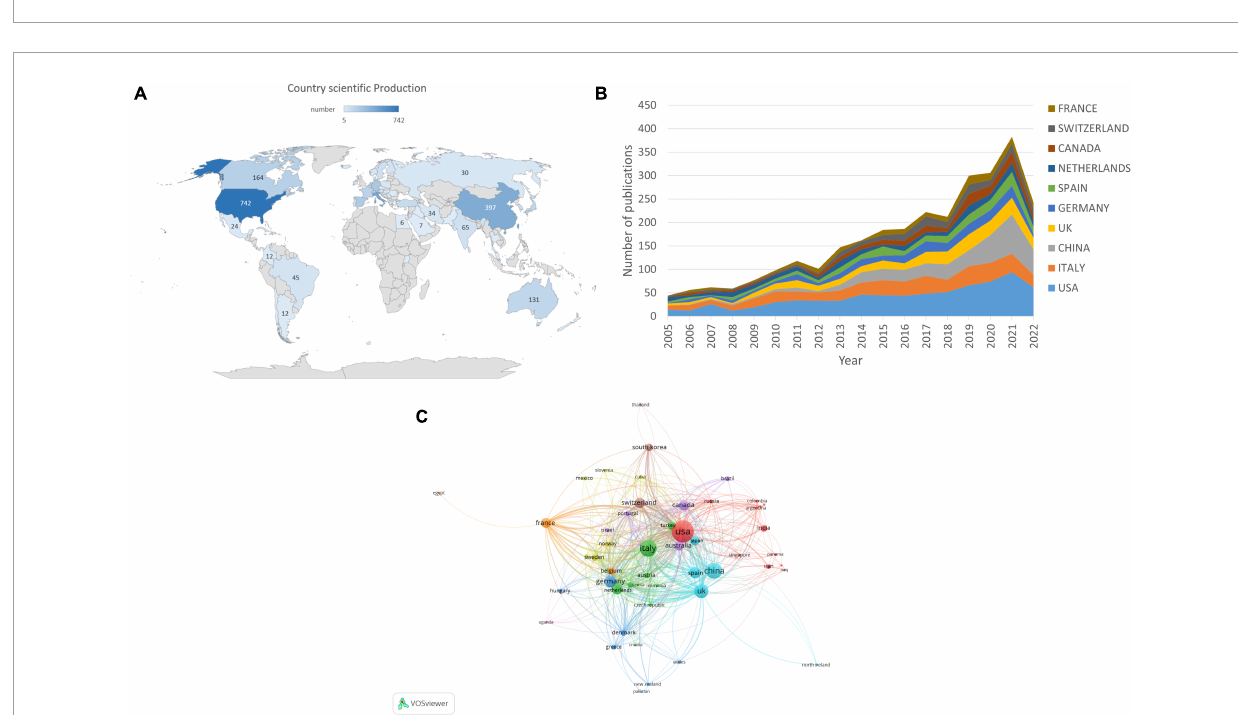
FIGURE2 The annual number of publications and growth rate on EEG in MCI between 2005 and 2022.